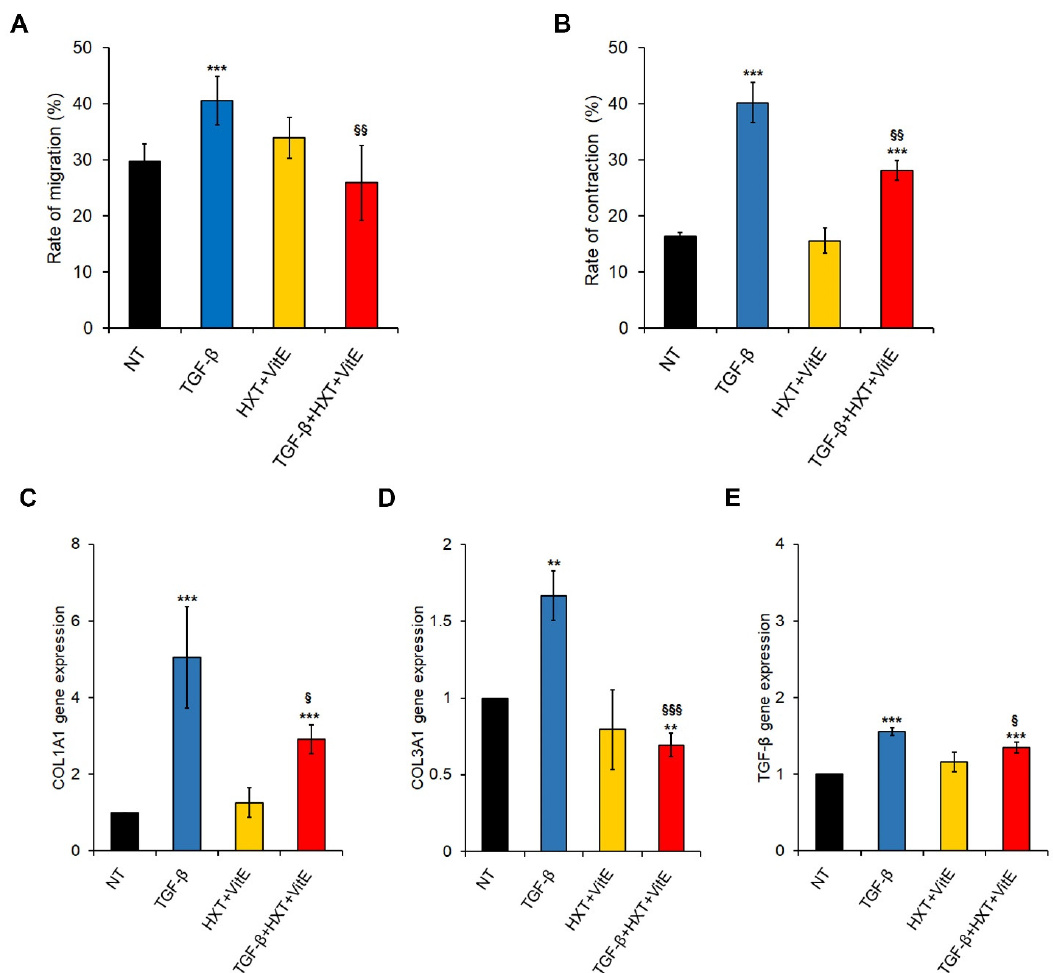
Figure 2. HXT + VitE attenuates TGF- β -induced myofibroblast-like and pro-fibrogenic phenotype in LX-2 cells. ( A ) Rate of migration by gap closure assay expressed as percentage in LX-2 cells NT, treated with HXT + VitE, or treated with TGF- β alone or with HXT + VitE at 0 and 12 h. Data are expressed as the mean ± SD of three independent experiments. *** p < 0.001 vs. NT; §§ p < 0.01 vs. TGF- β . ( B ) Analysis of the three-dimensional gel contraction assay in LX-2 cells NT, treated with HXT + VitE, or treated with TGF- β alone or with HXT + VitE at 0 and 24 h. Data are expressed as the mean ± SD of three independent experiments. *** p < 0.001 vs. NT; §§ p < 0.01 vs. TGF- β . Gene expression by qRT-PCR of COL1A1 ( C ), COL3A1 ( D ), and ( E ) TGF- β € in LX-2 cells NT, treated with HXT + VitE, or treated with TGF- β alone or with HXT + VitE for 24 h. Data are expressed as the mean ± SD of three independent experiments. ** p < 0.01 and *** p < 0.001 vs. NT; § p < 0.05; and §§§ p < 0.001 vs. TGF- β